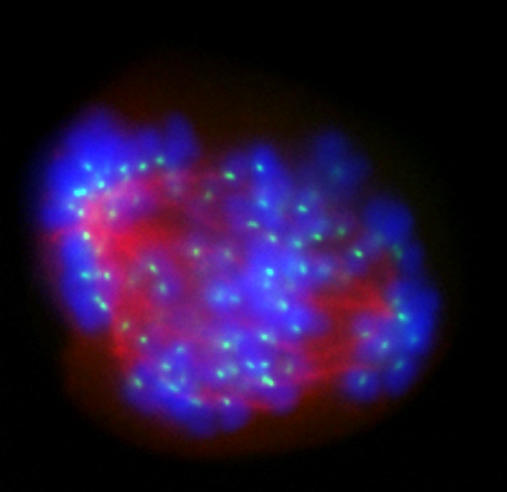
Premature loss of sister chromatid cohesion